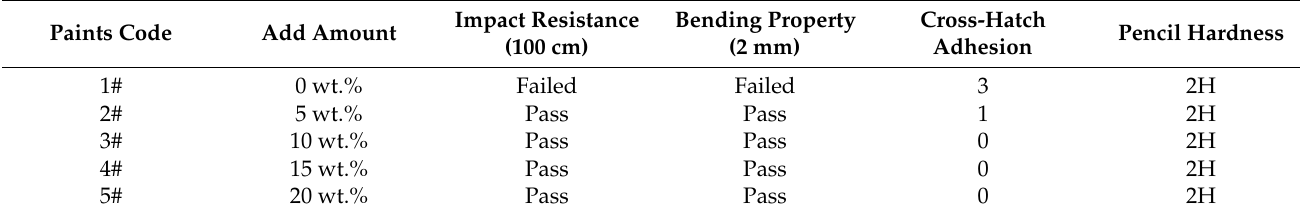
Table 4. Basic physical properties table of waterborne polymer-based paints.